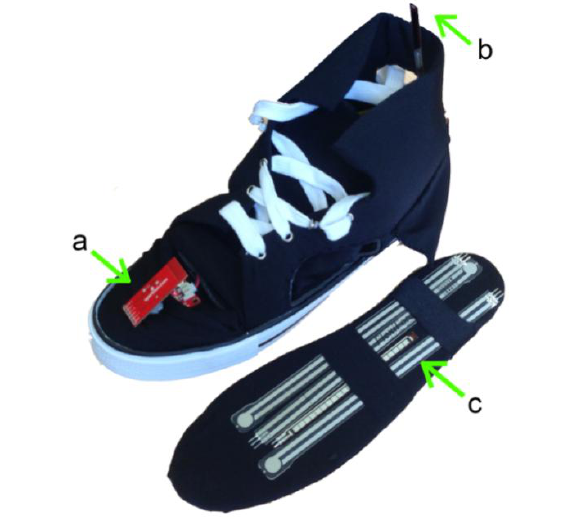
Figure 7. Instrumented shoe from Smartxa Project: ( a ) inertial measurement unit; ( b ) flexible goniometer; and ( c ) pressure sensors which are situated inside the